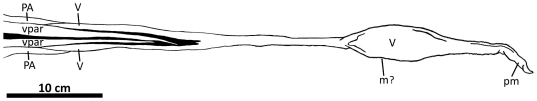
Vomer of Acrocanthosaurus atokensis (NCSM 14345) in
ventral view.
m, maxillary contact; PA, palatine;
pm, premaxillary contact; V, vomer;
vpar, vomeropalatine ramus of pterygoid.